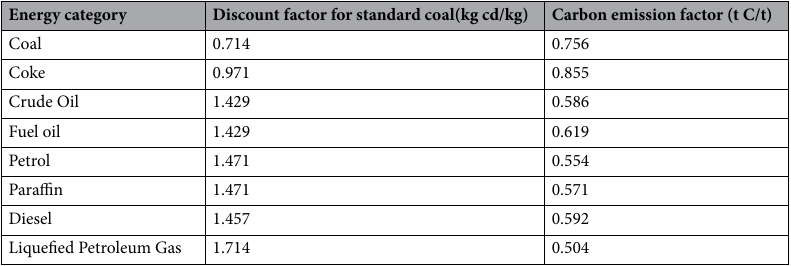
Table 3. Carbon Emission Estimation Coefficient of Construction Land in Yellow River